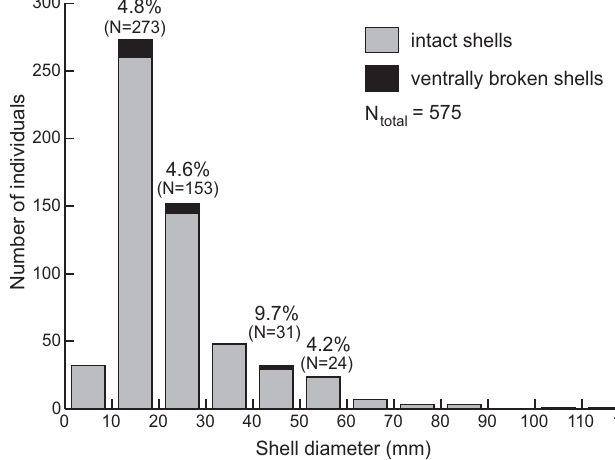
Fig. 7. Size distribution of ventrally intact and damaged early Toarcian am- monoid specimens from the Toyora area. Percentage represents the break- age frequency in each size class.